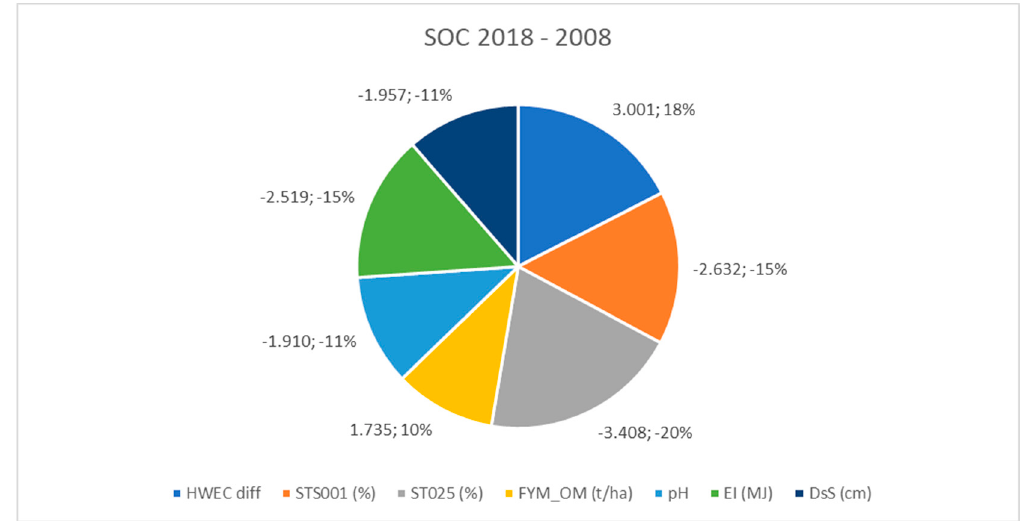
Figure 9. Importance of variables for model SOC Difference between the years 2018 and 2008.